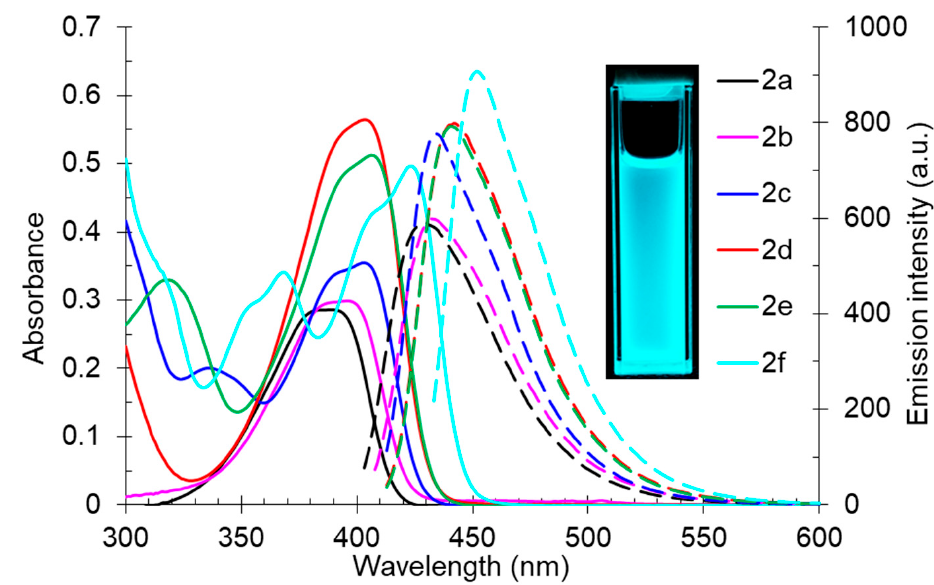
Figure 3. UV-vis absorption (5 × 10 − 5 M, solid lines) and emission (5 × 10 − 5 M, dashed lines) spectra of compound 2 in toluene. A photo of solution 2f in toluene was taken under 365 nm of irradiation. Compound 2 also showed good photoluminescence in the individual form in the crystalline state (Table 3, Figure 4). It was found that the emission maxima of the com- pounds lay in the range of 474–547 nm, corresponding to a wide range from the blue-green to yellow-orange regions of the visible spectrum, and in most cases, short-wavelength emissions were much more intense. These observations indicated that derivatives 2b and 2f, showing red-shifted emission maxima with pronounced shoulders, were prone to ag- gregation with subsequent fluorescence quenching, while compound 2d , on the contrary, demonstrated the highest photoluminescence intensity and a narrow emission band.